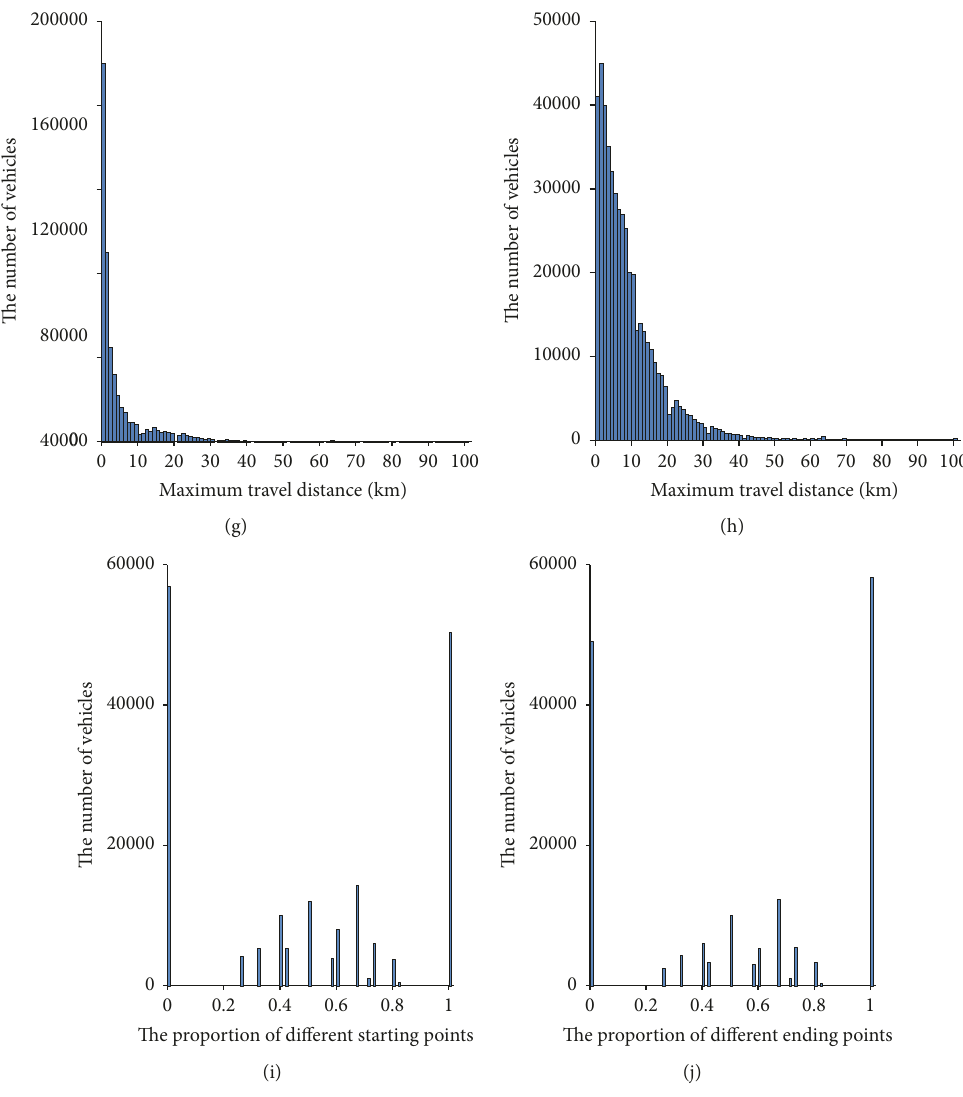
Figure 4: The distribution of variables in weekdays. (a) The average trip start time. (b) The average trip finish time. (c) Number of trips per day. (d) Days of travel. (e) Total activity duration. (f) Maximum travel distance. (g) Minimum travel distance. (h) Average travel distance. (i) The proportion of different staring points. (j) The proportion of different ending